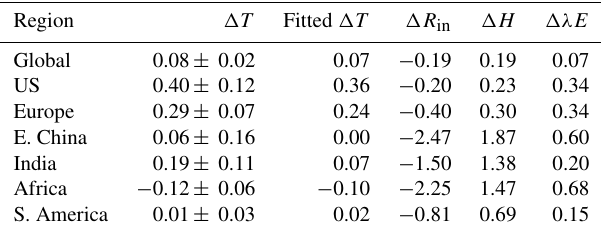
Table 4. Domain-averaged T and contributions from each radiative component estimated from the linear regression model for the BC experiment (unit: